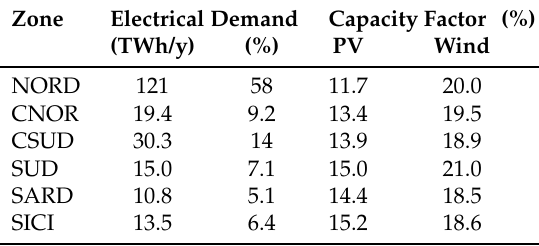
Table A1. Yearly electrical demand (from GME) and yearly mean PV and wind capacity factors (from Terna) averaged over